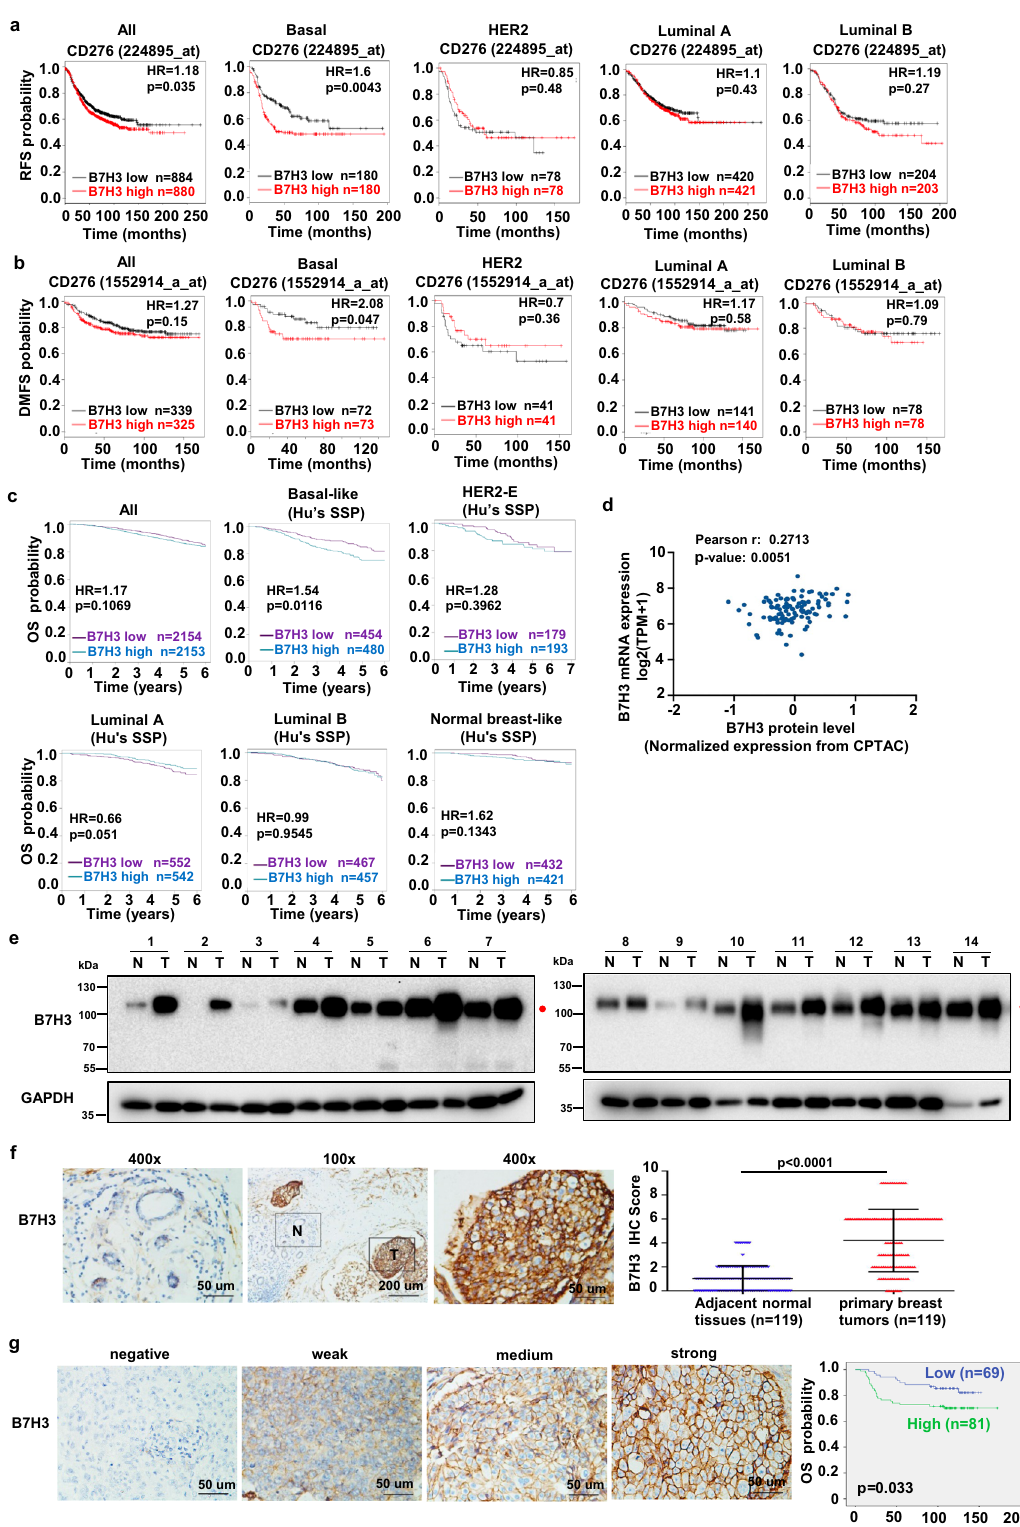
Pearson r: 0.2713 p -value: 0.0051